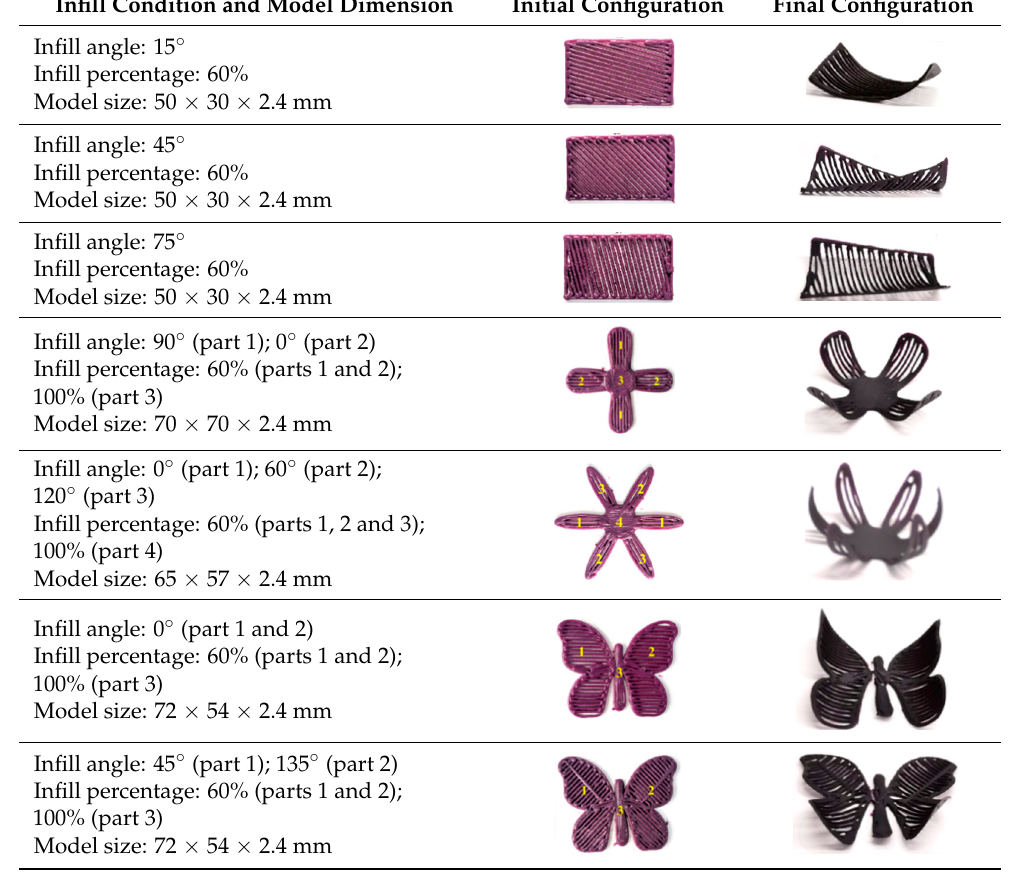
Table 1. Effect of filling angle and filling percentage on the product deformation (induced by dehydration) based on 4D printing (Reprinted with permission from He et al., [42]. © 2020, Elsevier Ltd., Amsterdam, The Netherlands) [42].